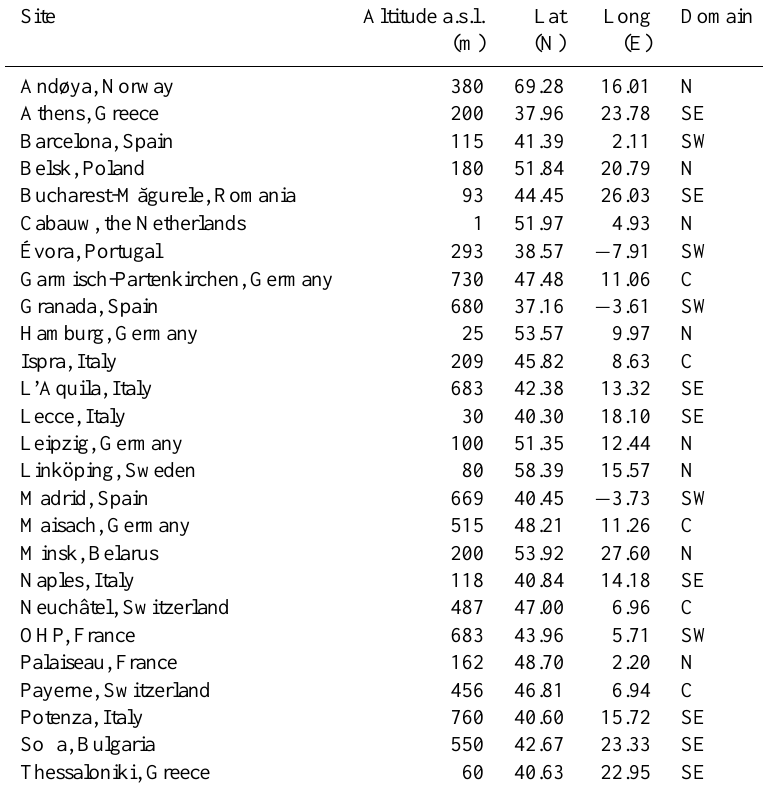
Table 1. Locations of EARLINET lidar stations, their geographical coordinates and corresponding domain assigned (C: central Europe; N: north-central Europe; SW: Iberian Peninsula; SE: